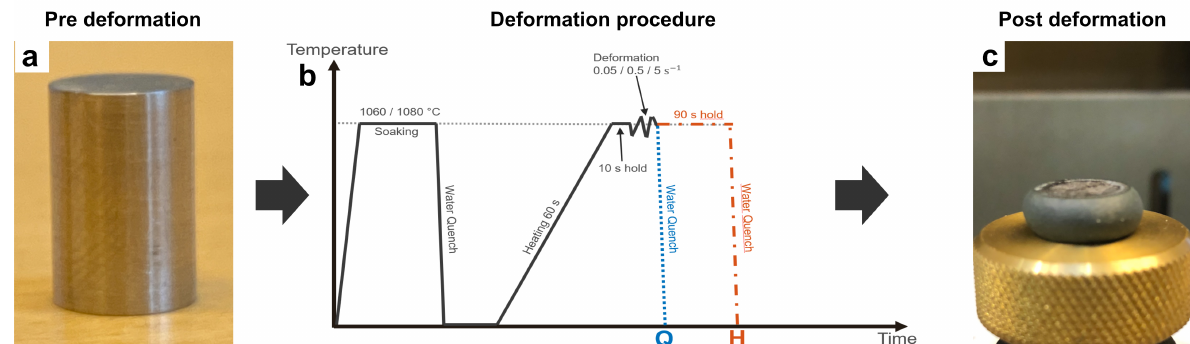
Figure 1. ( a ) Cylindrical sample before deformation (height 12 mm, diameter 8 mm). ( b ) Experimental procedure of the Gleeble testing. Blue lines represent the Q samples (quenched directly after deformation) and orange lines represent the H samples (held at temperature for 90 s after deformation prior to quenching). ( c ) Sample after deformation, showing